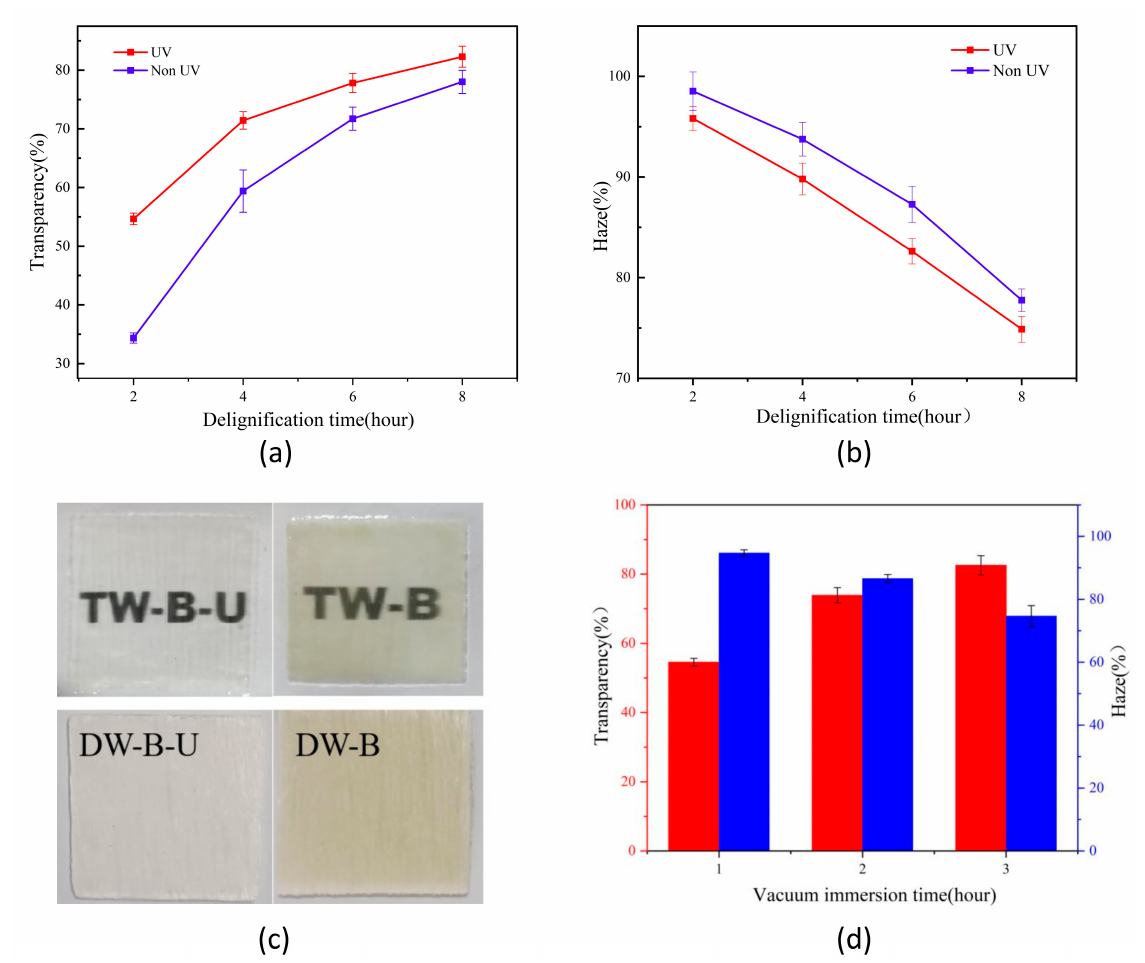
Figure 4. Transmittance ( a ) and haze ( b ) of eight groups of “transparent wood” was obtained by soaking the wood in a lignin-modifying solution under UV-assisted or dark conditions for 2 h, 4 h, 6 h and 8 h, followed by a 3 h impregnation treatment, respectively. ( c ) Photographs of TW-B-U, TW-U, DW-B-U and DW-B under daylight source. ( d ) The transmittance and haze of TW-B-U1, TW-B-U2 and TW-B-U were obtained by changing the impregnation time.